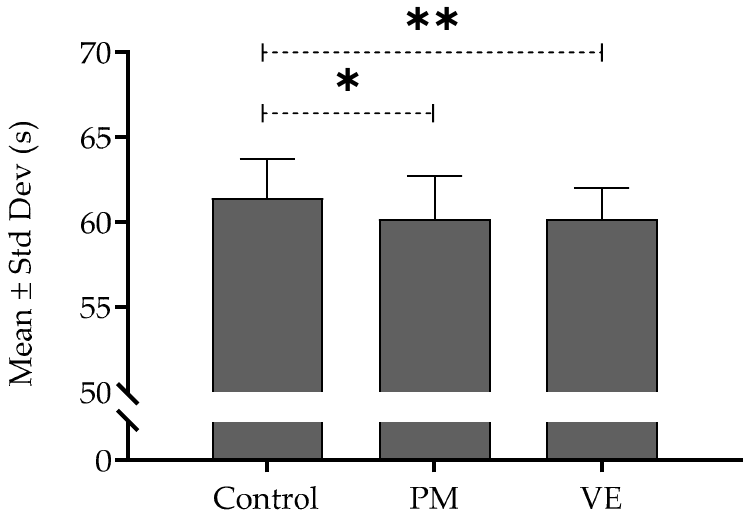
Figure 2. Descriptive statistics for total time (TT) in three conditions (Control, PM—listening of the preferred music, VE—verbal encouragement), and post-hoc differences between conditions (** denotes significance of p < 0.01, * denotes the significance of p < 0.05).